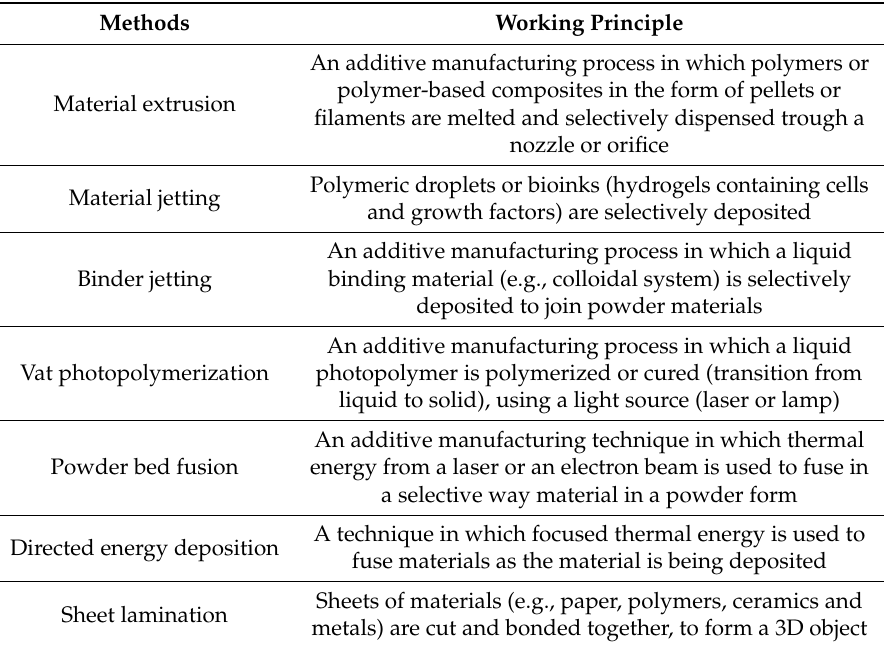
Table 1. Additive manufacturing